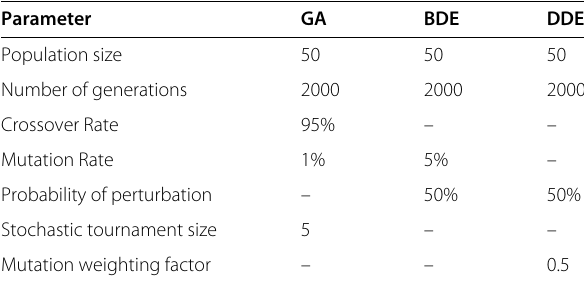
Table 5 Parameters used by the EA methods